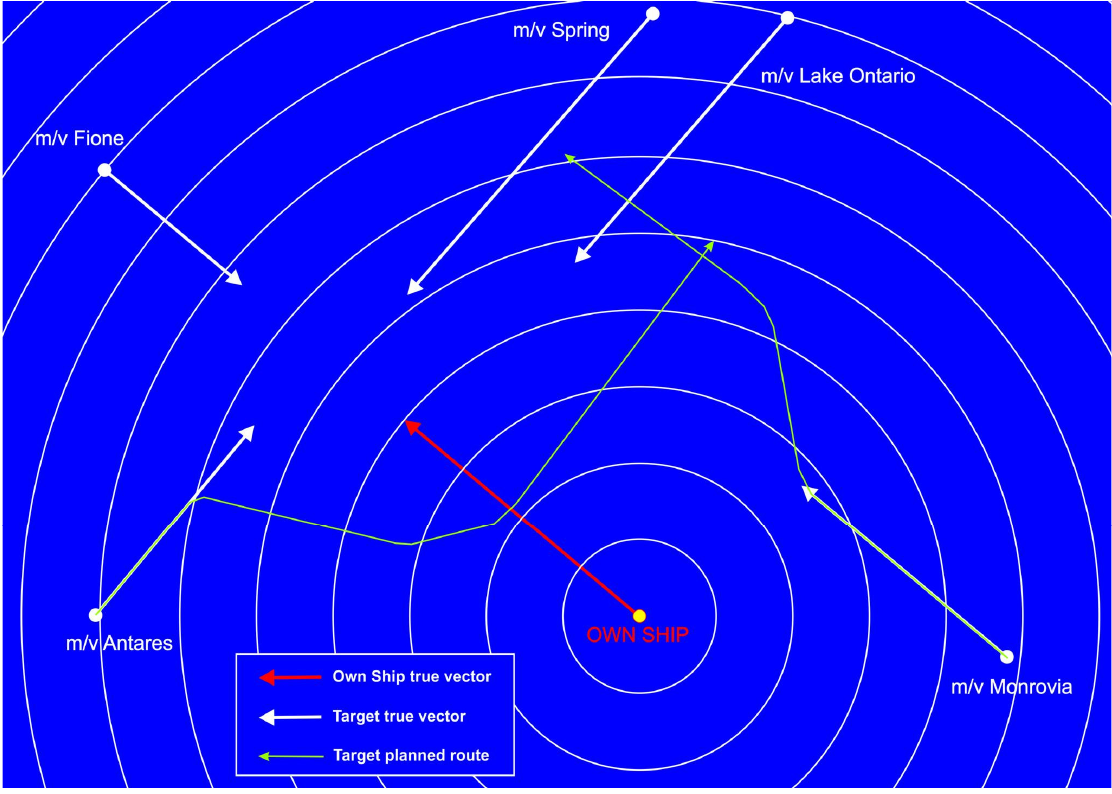
Figure 6. Initial navigational situation in open water area. Radar range 6 NM.